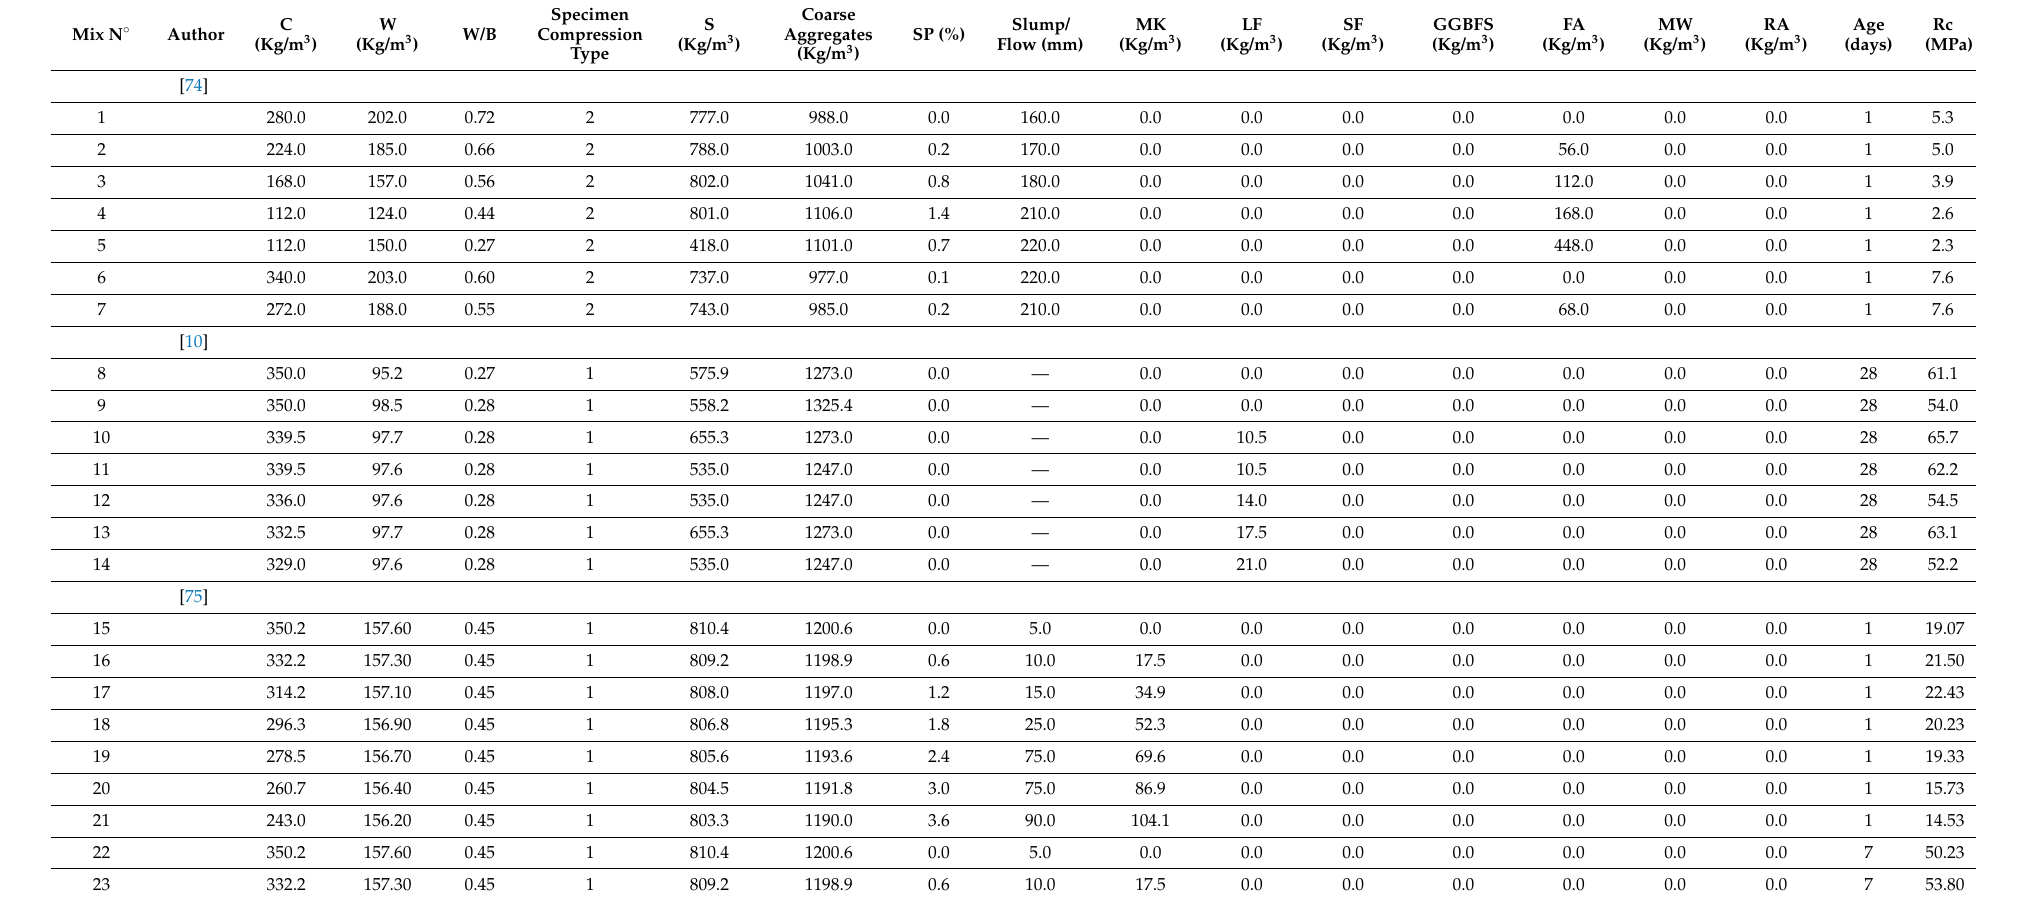
Table 4. Excerpt of dataset used in AI training and validation